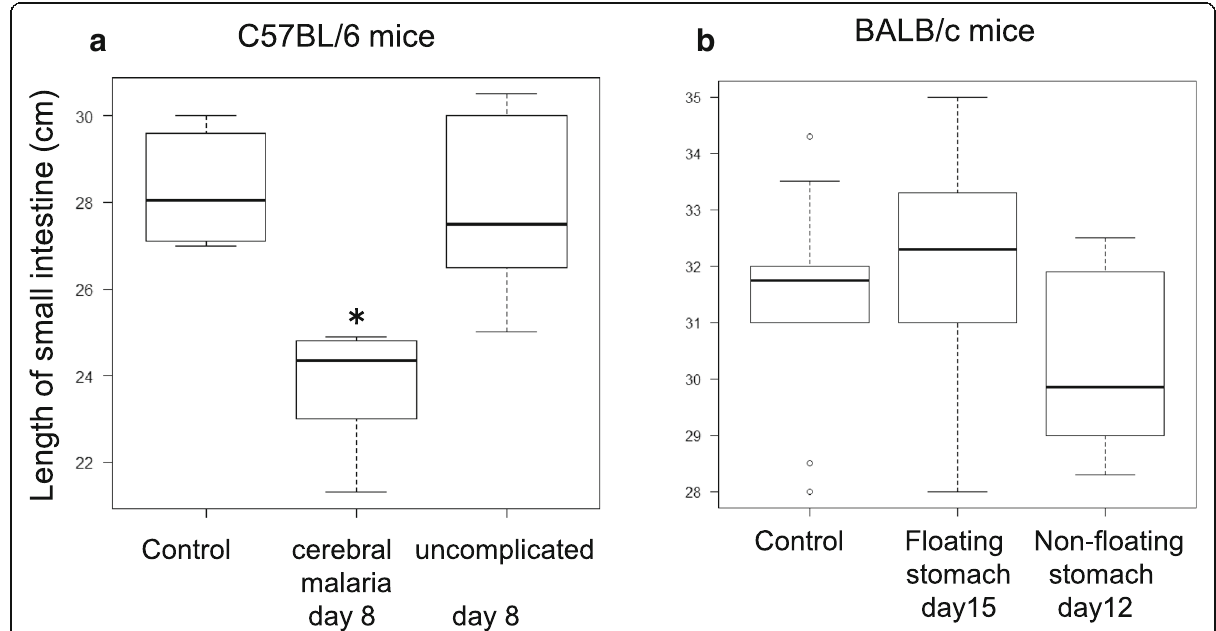
Fig. 5 The length of the small intestine in PbA-C57BL/6 mice, PbA-BALB/c mice, and uninfected control mice. a Intestinal length in uninfected C57BL/6 mice ( n = 10), PbA-C57BL/6 mice with cerebral malaria and floating stomachs ( n = 6), and uncomplicated PbA-C57BL/6 mice with no floating stomachs ( n = 9). b Comparison of intestinal length in uninfected BALB/c mice ( n = 10), PbA-BALB/c mice with floating stomachs on day 15 ( n = 6), and PbA-BALB/c mice without floating stomachs on day 12 ( n = 6). * p <